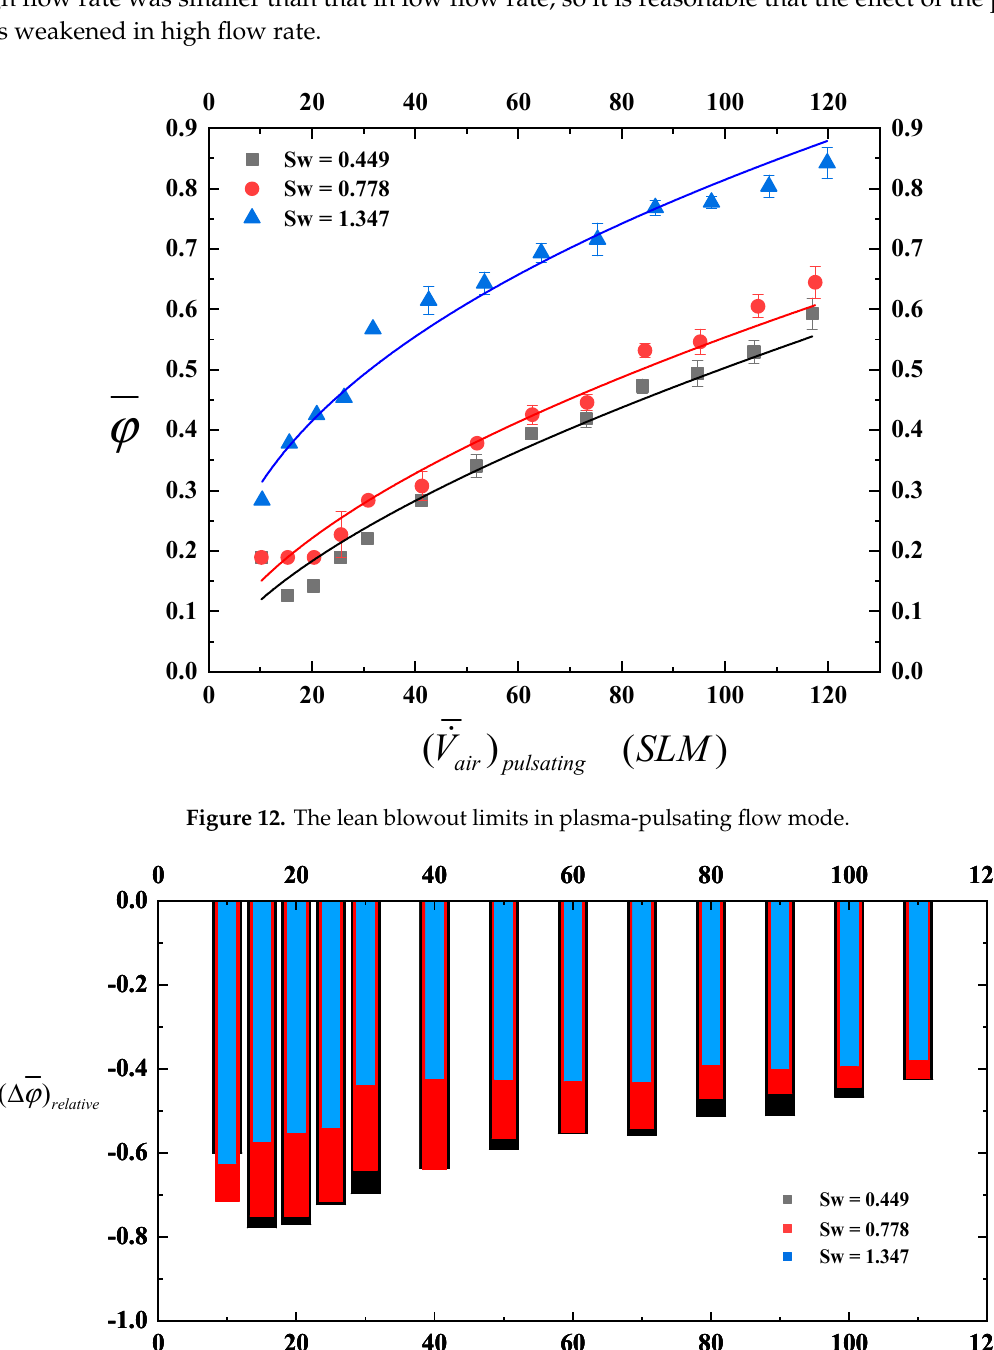
Figure 13. The relative decreases in equivalence ratio when gliding arc plasma was applied to the pulsating flame.